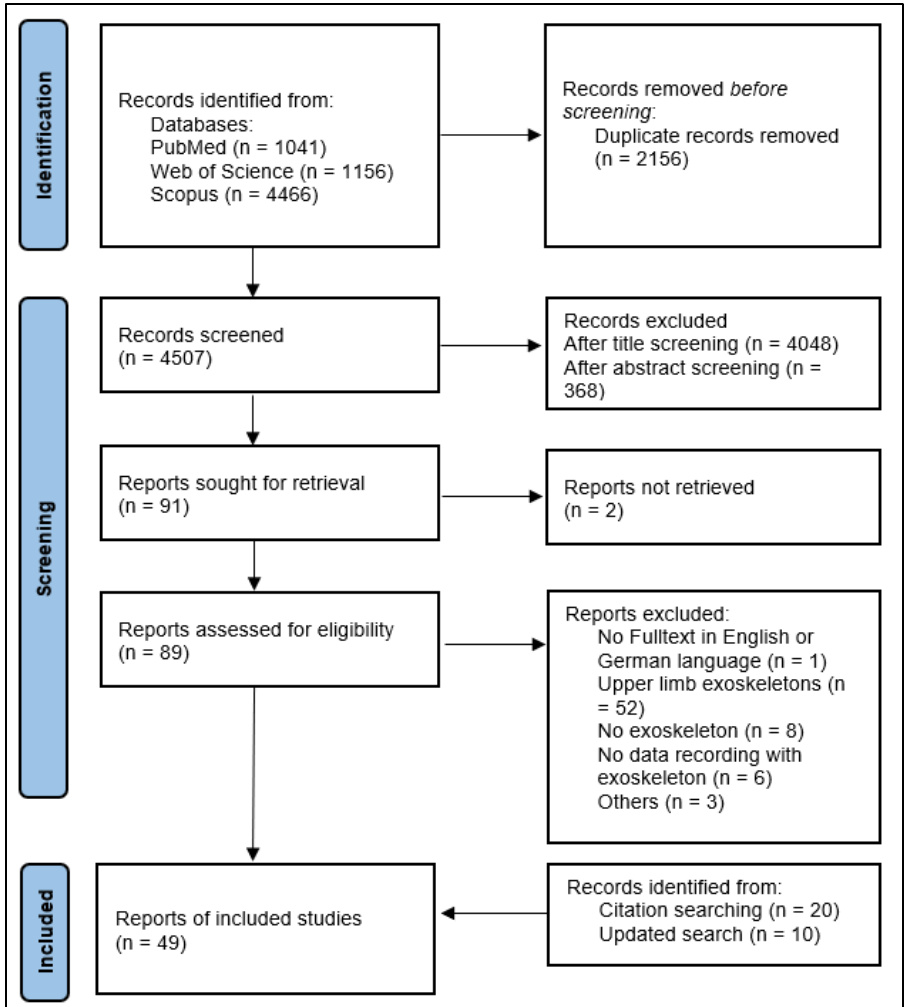
Figure 2. Flowchart of study section process (adapted according to [33,85]).